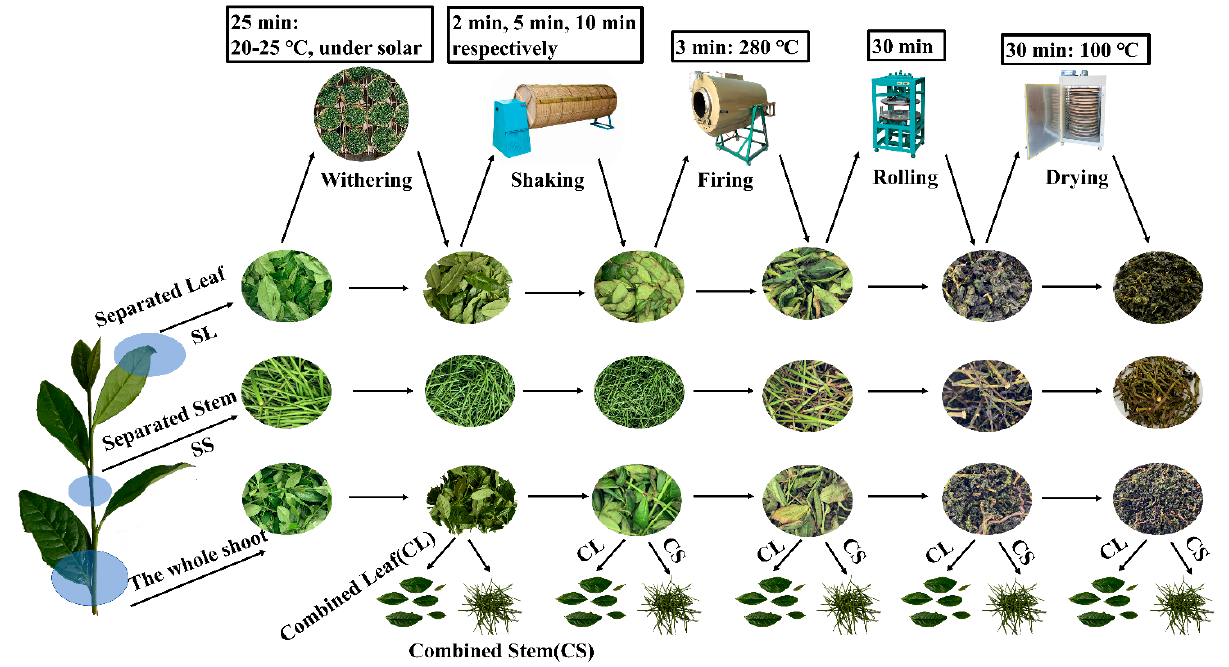
Figure 1. Manufacturing processes of oolong